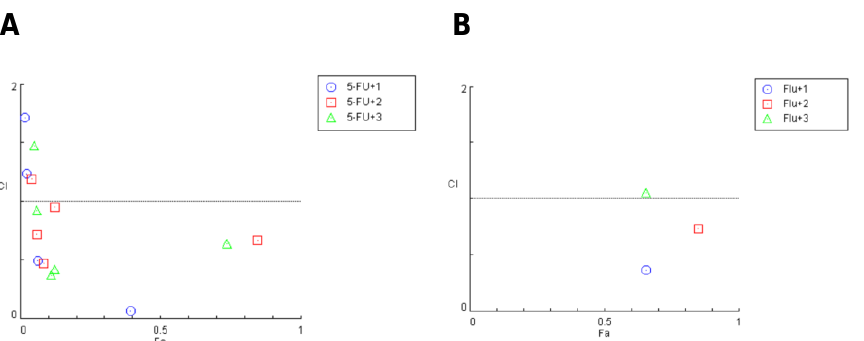
Figure 6. Fa-CI plot of combined treatments of ( A ) 5-FU and ( B ) fluphenazine combined with (1) green propolis, (2) red propolis and (3) brown propolis on HT-29 colon cancer cells. The combination index was calculated using CompuSyn software. CI < 1, =1, and >1 indicates synergistic, additive, and antagonistic effects, respectively. Table 5. Nature of drug interactions in HT-29 colon cancer cells treated with fluphenazine and 5-FU combined with green, red and brown